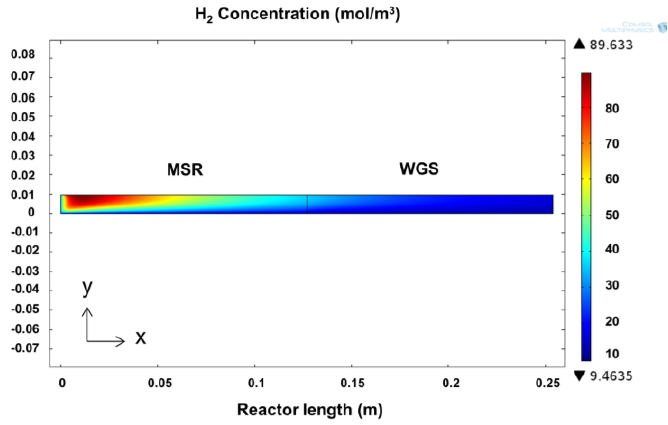
Figure 10. Concentration profile of H 2 inside in a dual MSR-WGS catalytic membrane reactor.